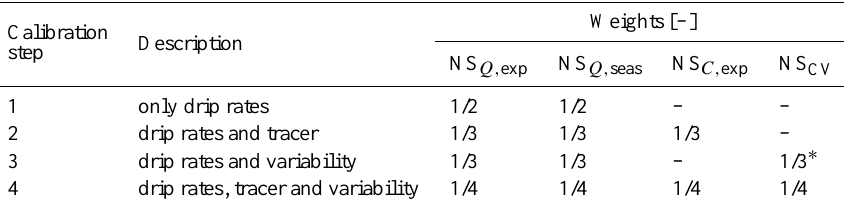
Table 2. Description of calibration steps and weights associated with the Nash Sutcliffe efficiencies concerning the drip rates observed during the experiment, NS Q, exp , the drip rates during the seasonal times scale, NS Q, seas , the drip water concentration during the experiment, NS C, exp , and their coefficients of variation, NS CV